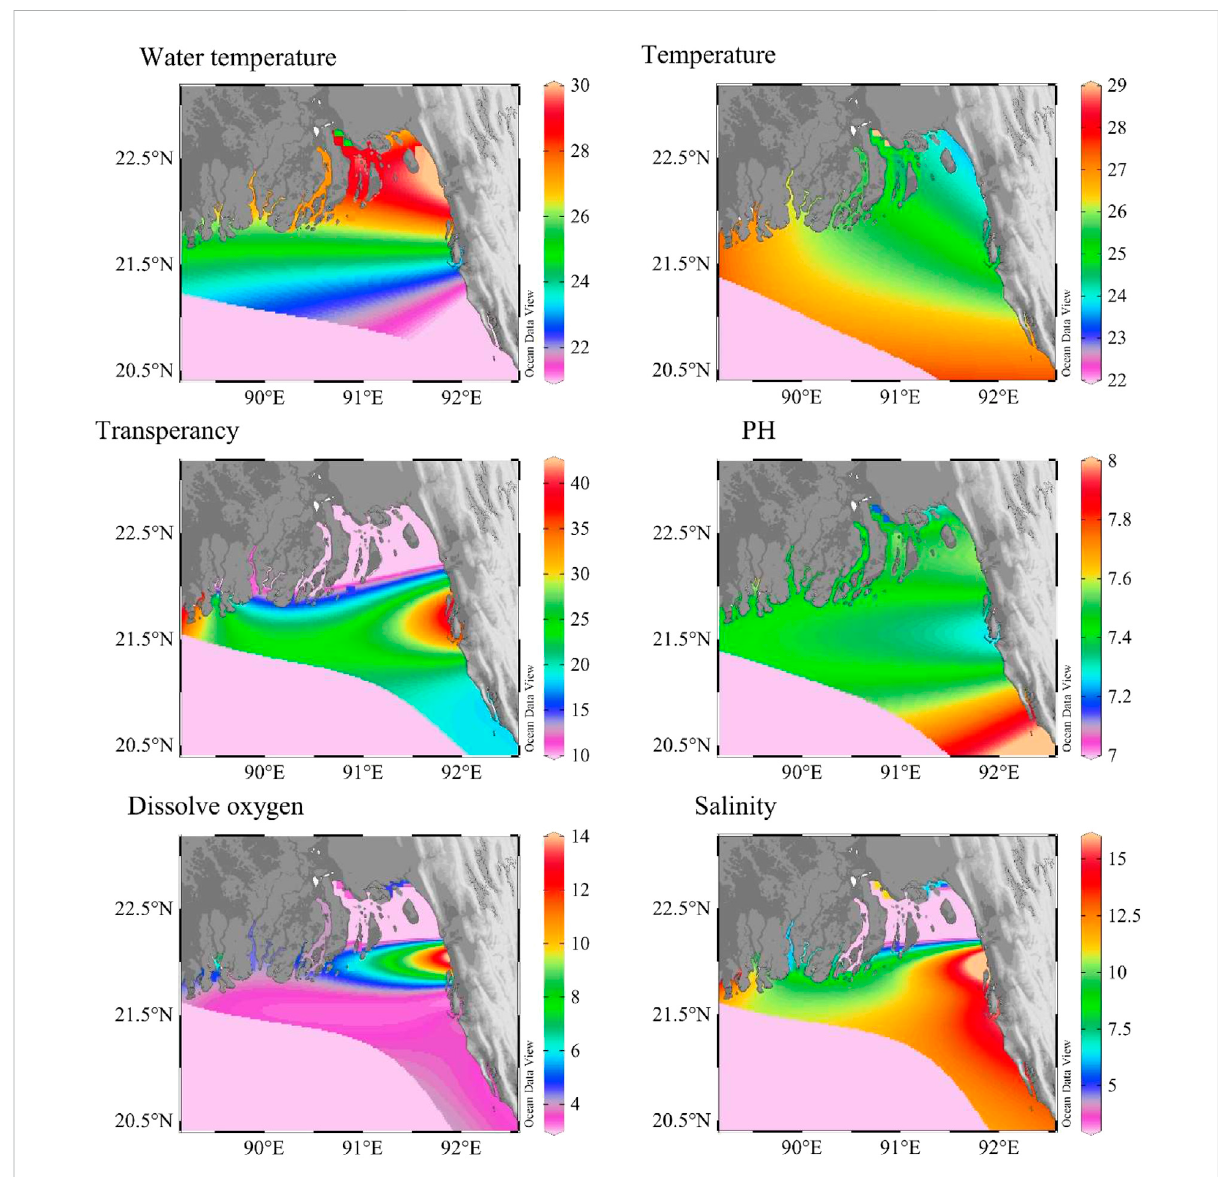
FIGURE 3 Average concentration of environmental parameters (A = water temperature, B = atmospheric temperature, C = transparency, D = pH, E = dissolved oxygen, and F = salinity) in the estuaries of Bangladesh (Greyish pink color indicated the data de fi cient